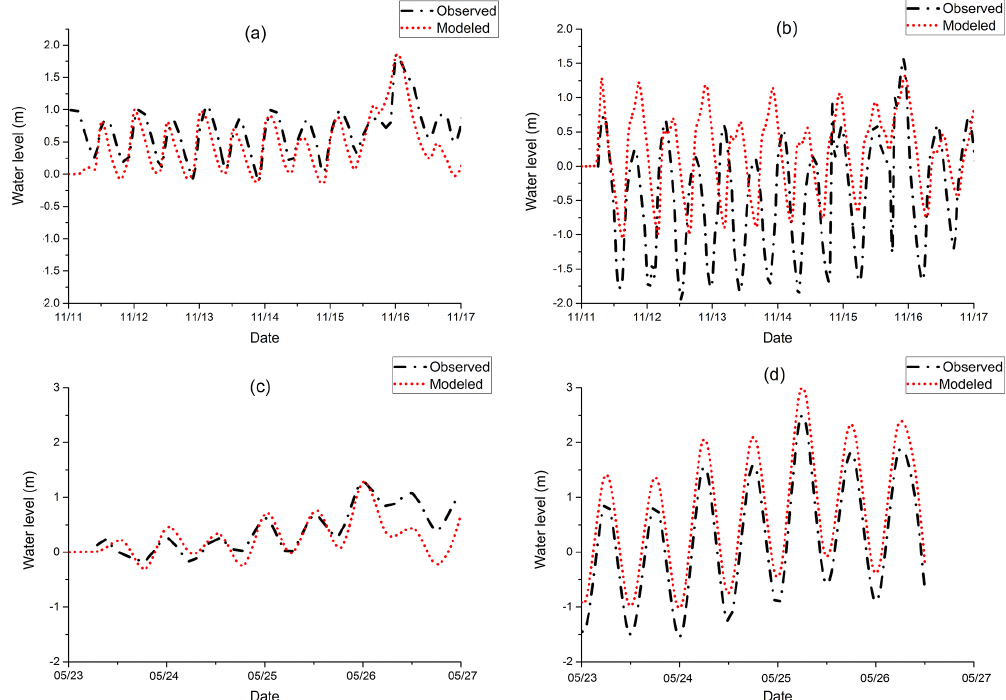
Figure 3. Comparison of observed and modelled water levels for TC Sidr and TC Aila at Barisal and Charchanga observation stations. (a) Measured and modelled water level comparison for TC Sidr in Barisal, (b) TC Sidr in Charchanga, (c) TC Aila in Barisal and (d) TC Aila in